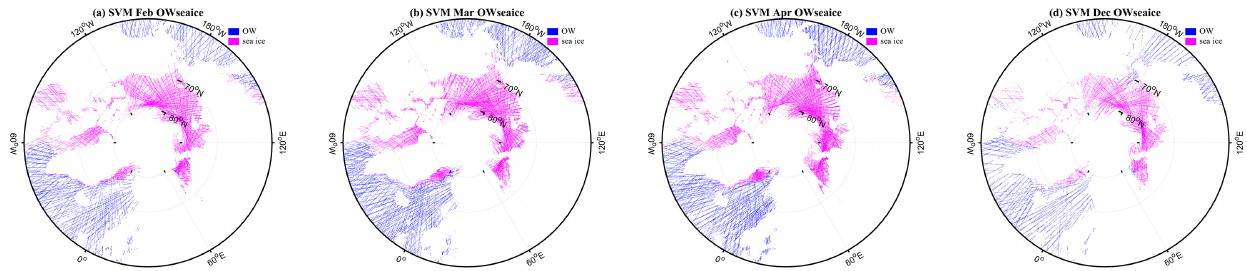
Figure A9. SVM for OW-sea ice classification using the data in November as the training set. The data in ( a ) February, ( b ) March, ( c ) April, and ( d ) December are used as the test set in turn.